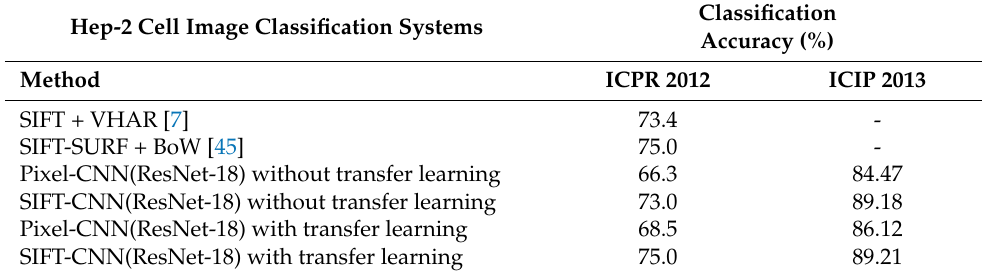
Table 1. Classification results for the Hep-2 cell image biomedical